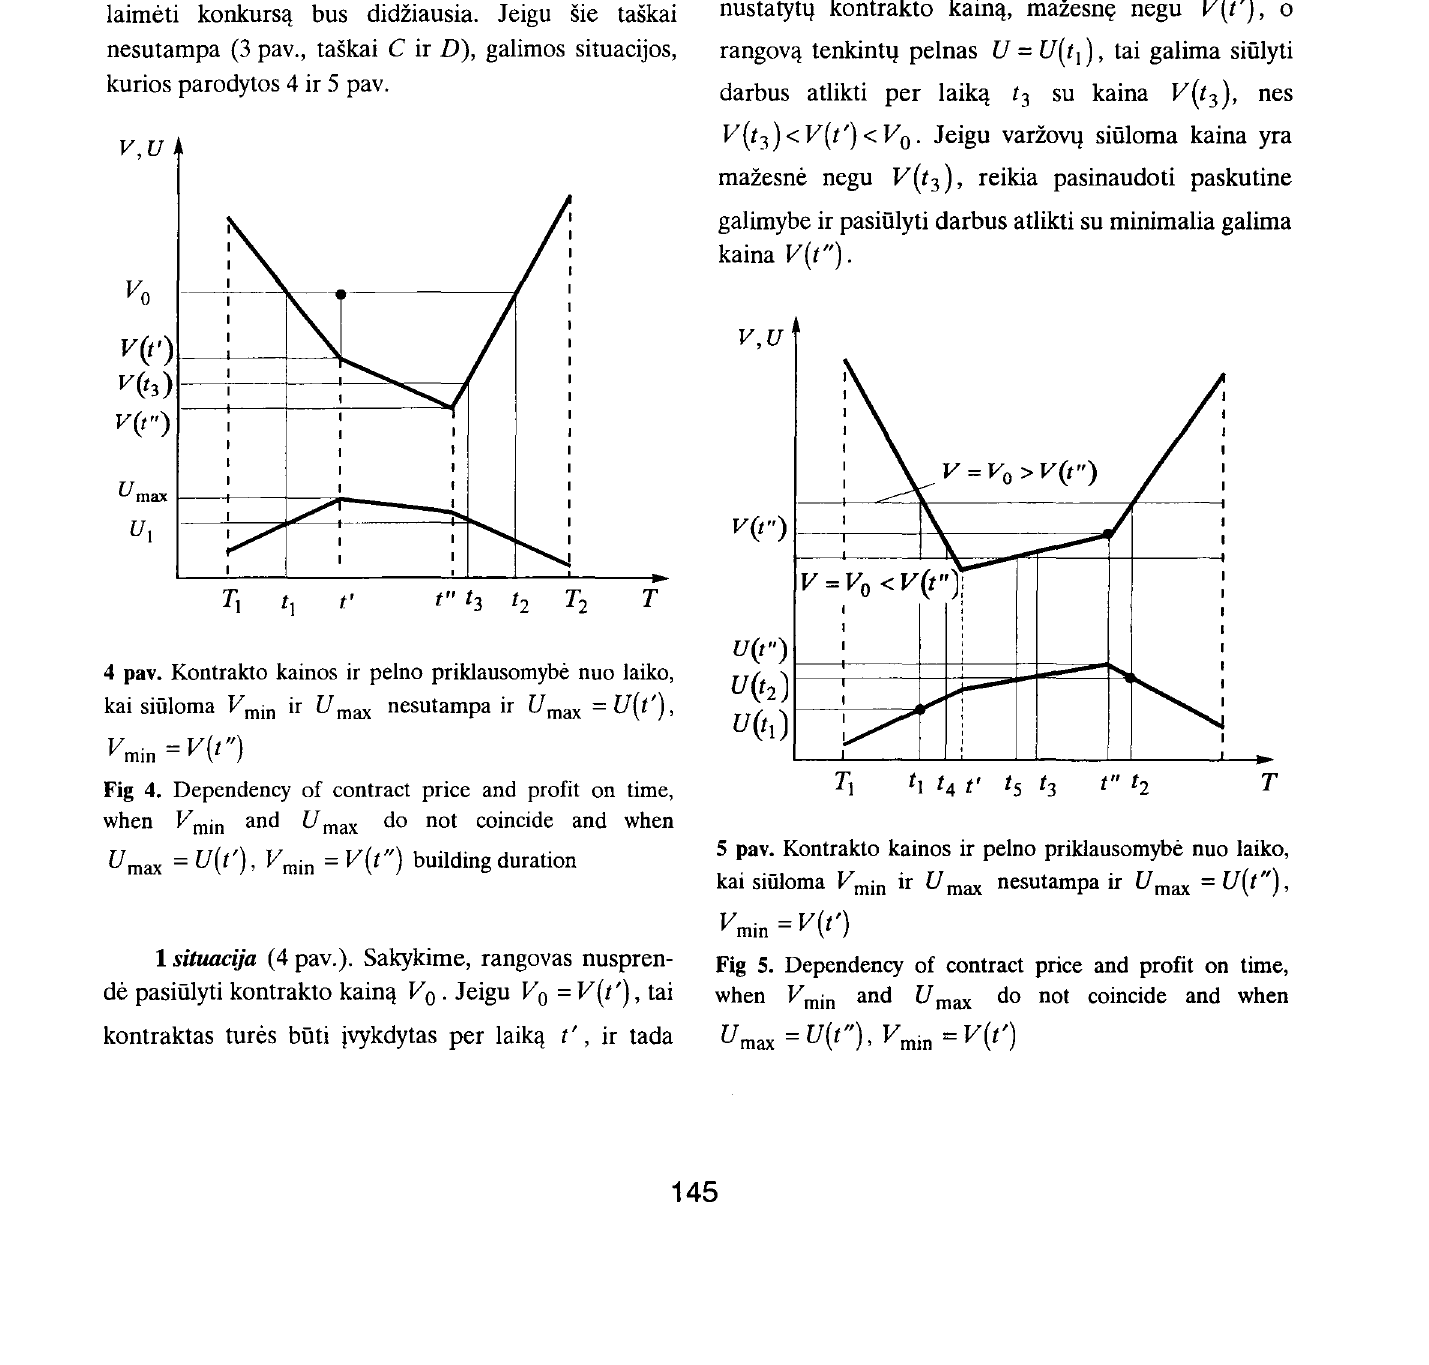
Fig 5. Dependency of contract price and profit on time, when V min and U